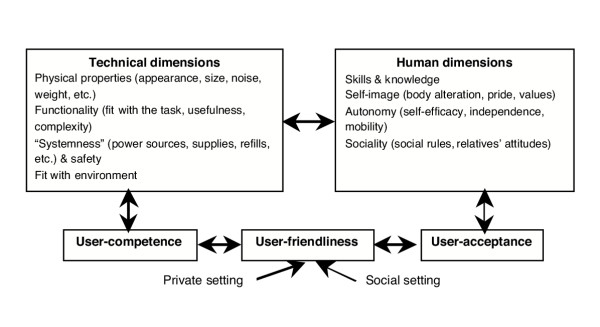
Technical and human dimensions that shape the user-friendliness of a technology (drawing on 12 and 13)